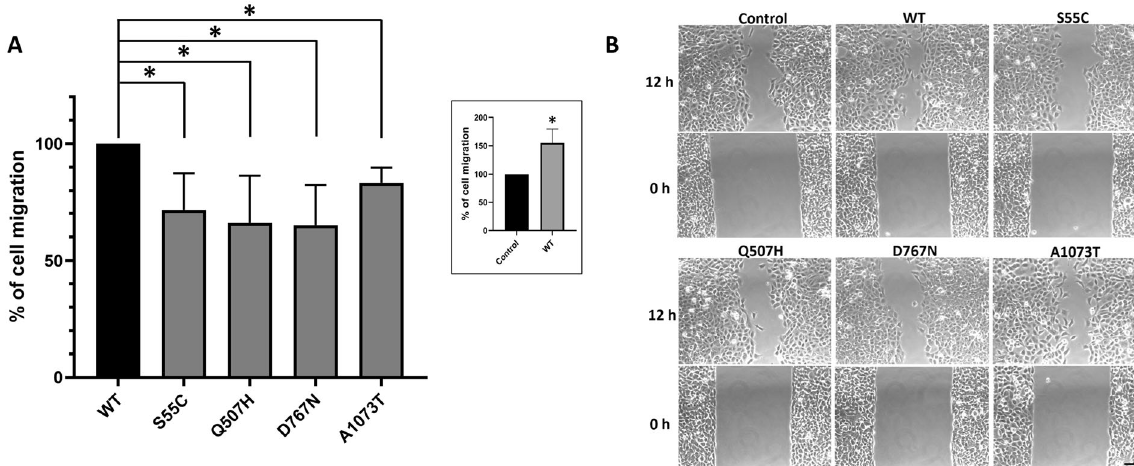
Fig. 5 Variants of CCDC141 identi fi ed in patients with self-limited delayed puberty result in impaired cell migration. Scratch assay was carried out in CCDC141 -overexpressing HEK293 cells. A percentage of cell migration (wound closure) at 12 h in mutant-transfected vs. WT- transfected HEK293 cells ( n = 3). The inset to A shows the percentage of cell migration of WT cells, compared to that of non-transfected cells as control (100%). Error bars show SD. B Representative contrast light microscope pictures at 0 and 12 h. Scale bar, 100 µm, * p <